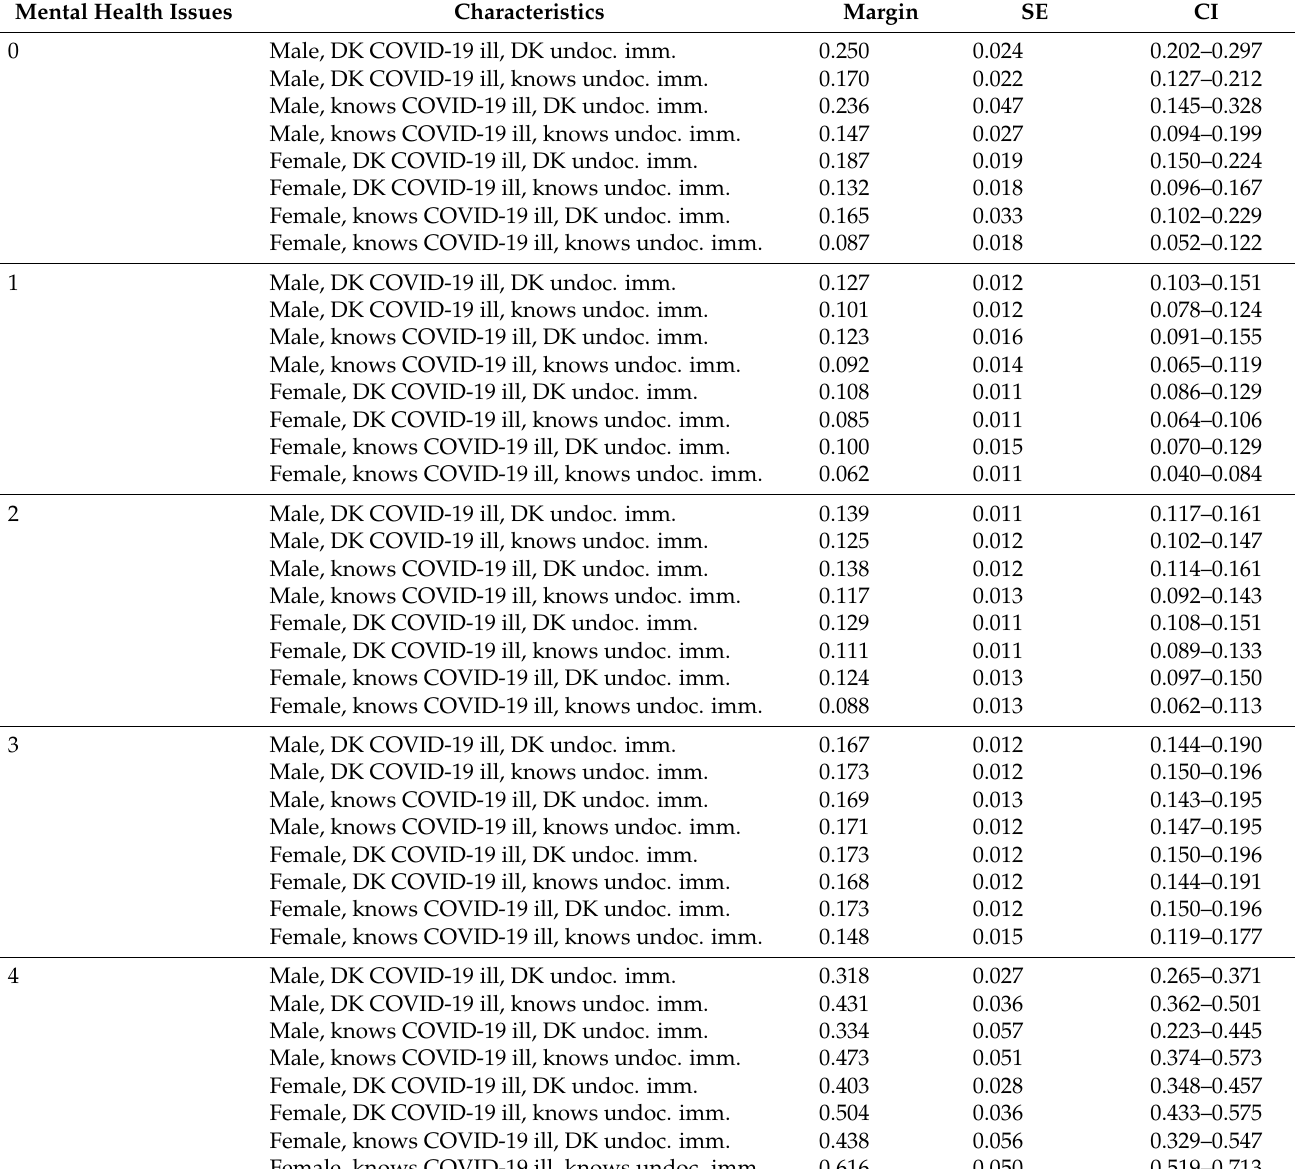
Table A1. Predicted probabilities of the three-way interaction among gender, knowing someone with COVID-19, and knowing an undocumented